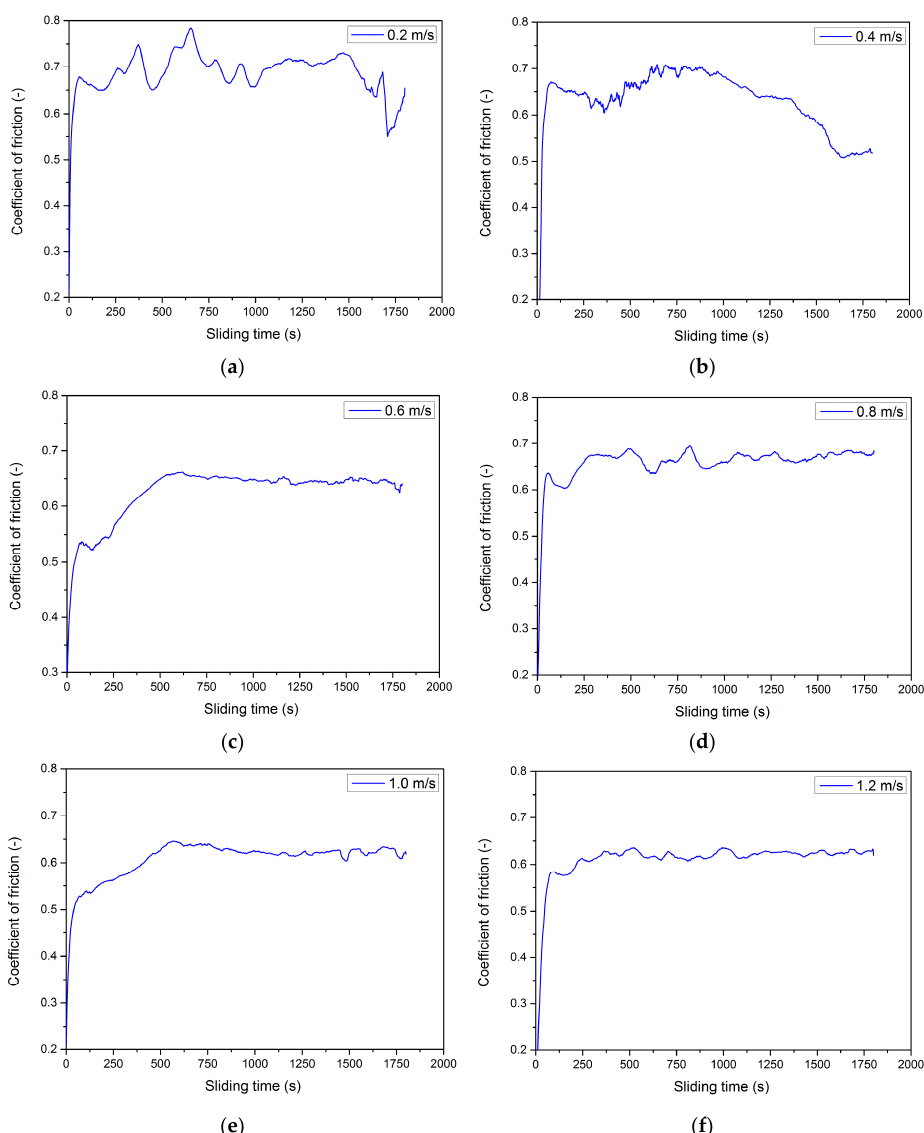
Figure 9. Resulting values of coefficient of friction for peripheral speed (m/s): ( a ) 0.2, ( b ) 0.4, ( c ) 0.6,